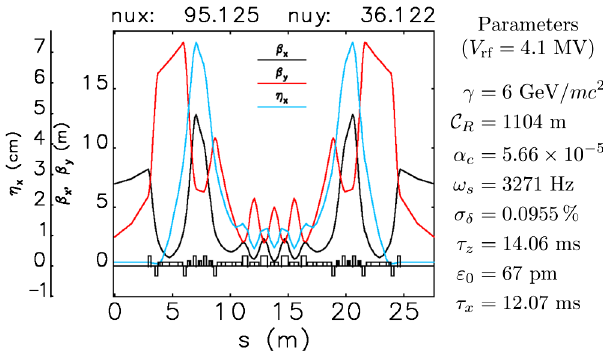
FIG. 1. Lattice Twiss functions and parameters used in the tracking simulations.